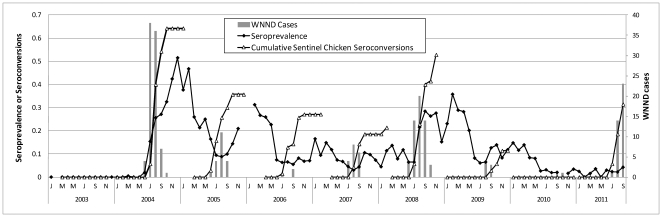
West Nile neuroinvasive disease (WNND) human cases, proportion seroprevalence of House Finches and House Sparrows combined, and cumulative sentinel chicken seroconversions plotted by monthly intervals, Los Angeles, California.